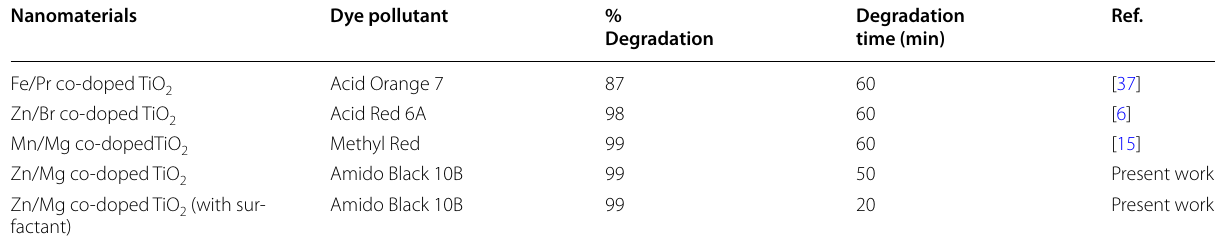
towards various dyes under visible light irradiation 2